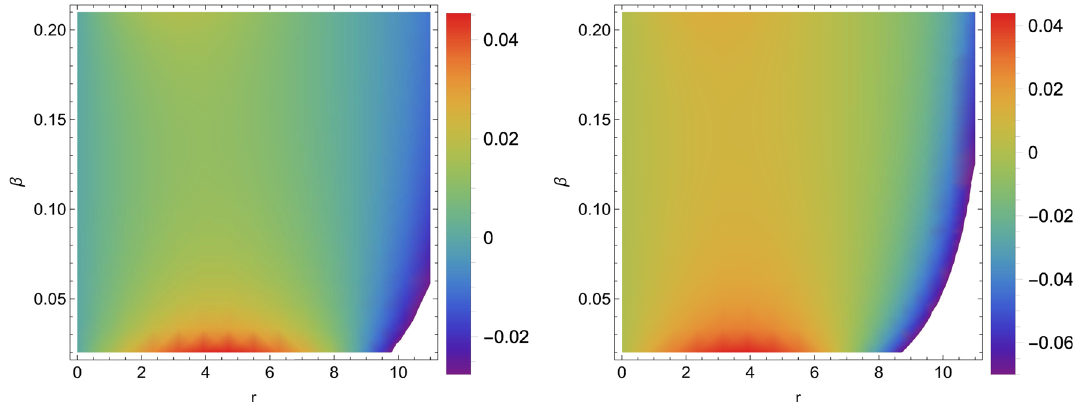
Fig. 11 The distribution of energy exchange ( (cid:4) E ) on ( r − β ) plane for A 2 = 0 . 5 (left panel) and A 2 = 1 (right panel)